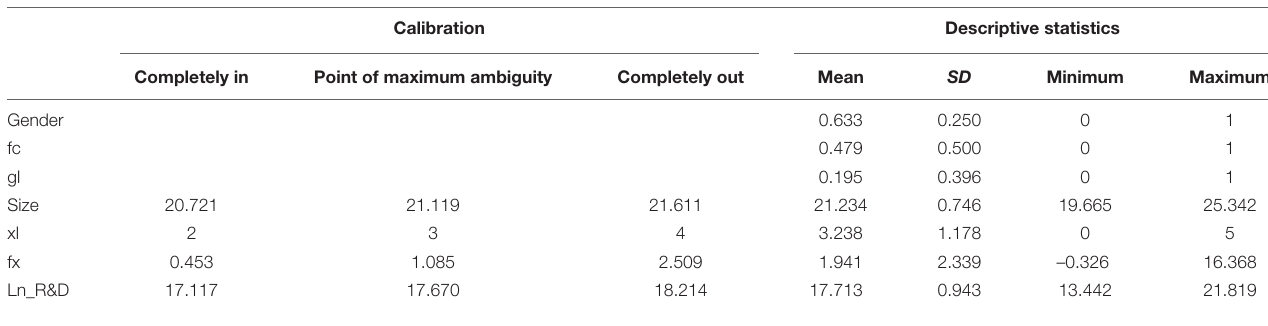
TABLE 2 | Innovation input calibration and descriptive